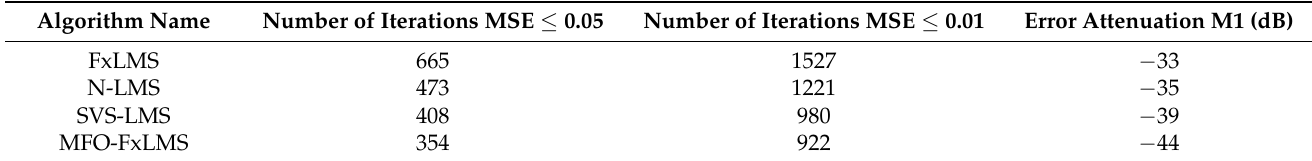
Table 2. Comparative results of the four